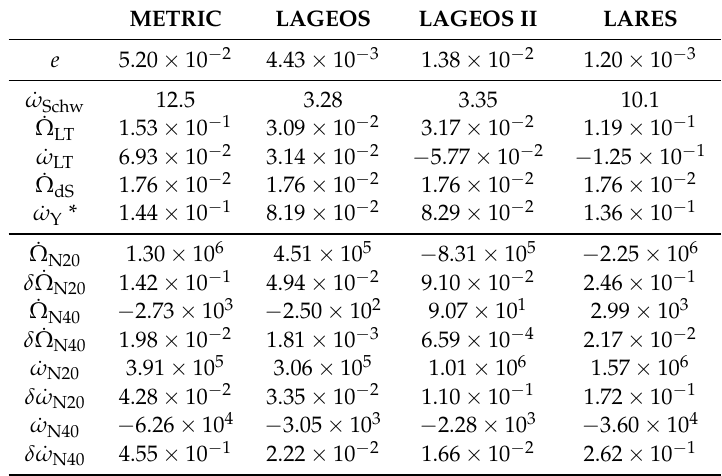
Table 2. Estimates of relativistic (upper part) and Newtonian (lower part) precession rates for METRIC and relevant geodetic satellites; all values are in arcsec y − 1 ; arcsec stands for a second of arc. For each satellite, the orbital eccentricity has been explicitly